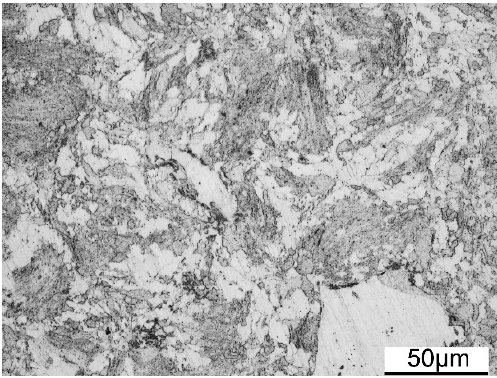
Figure 6. Optical microscope (OM) image of the as-HIPed ODS sample.